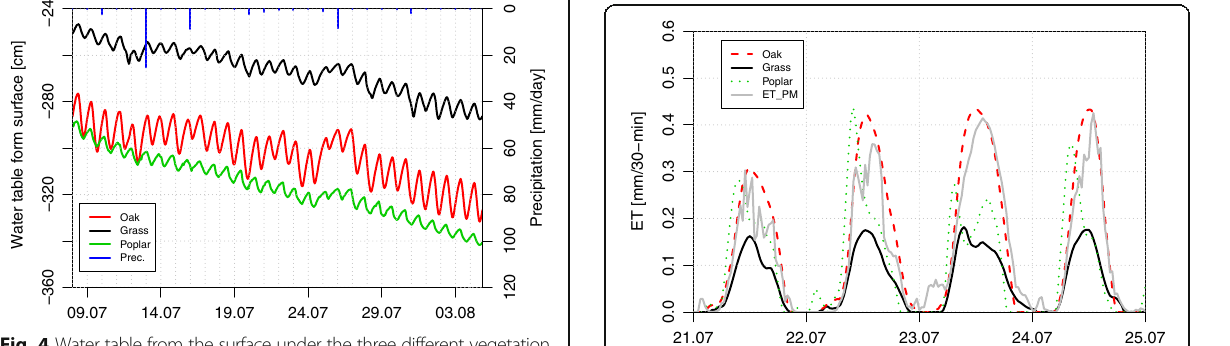
Fig. 4 Water table from the surface under the three different vegetation types in the summer of 2012